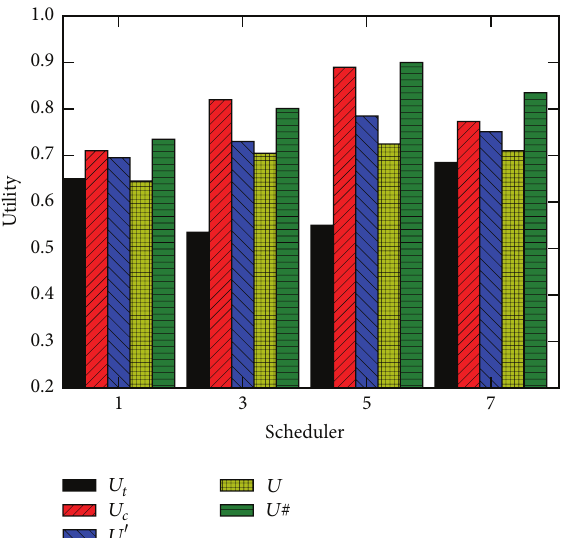
Figure 6: Utility distribution of cost sensitive user tasks.